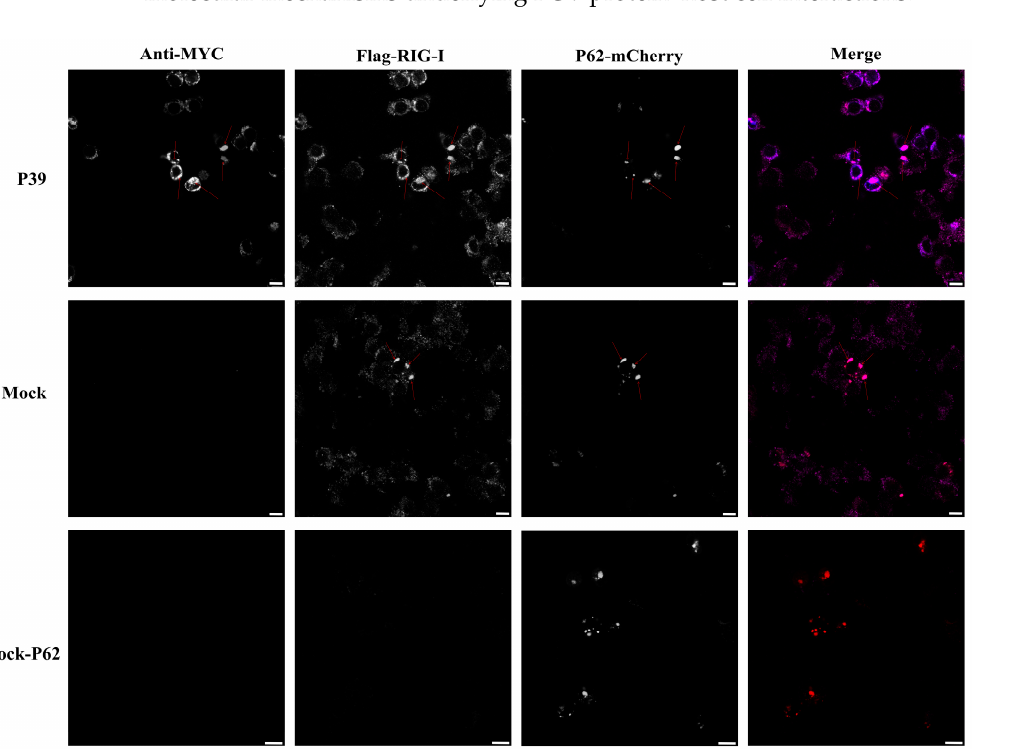
Figure 6. Co-localization of RIG-I, p39, and p62 in HEK-293T cells. HEK-293T cells were co-transfected with p39-myc, RIG-I-Flag, and p62-mCherry plasmids. Cells were stained for Myc (blue), flag (purple), and mCherry (red), and analyzed by confocal microscopy. Scale bar 10 µm.